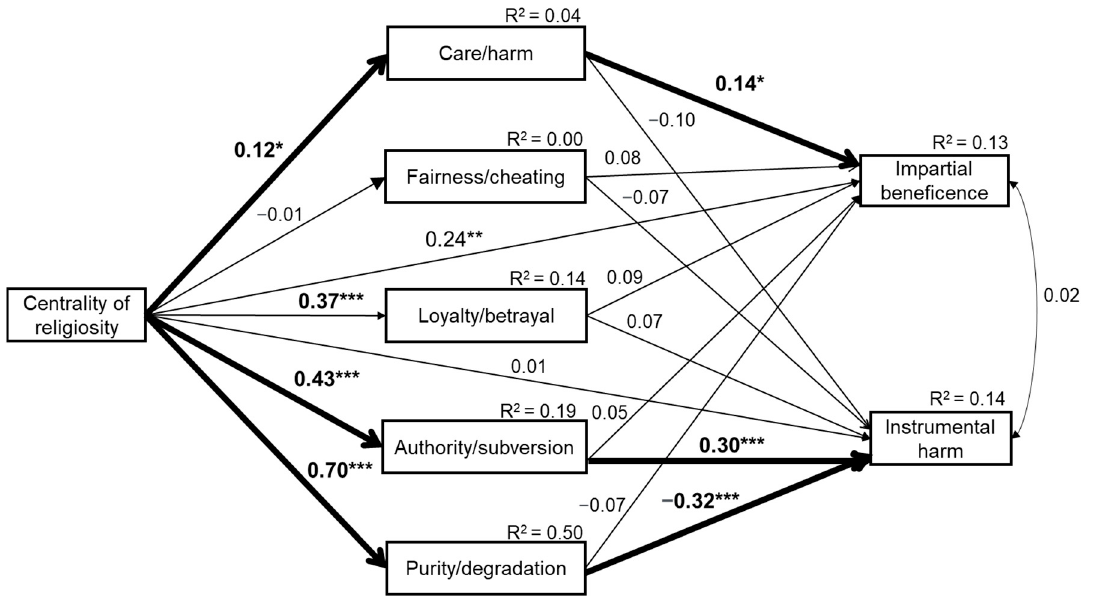
Figure 1. Multiple Mediation Model. * p < 0.05, ** p < 0.01, *** p < 0.001. The regression coefficients are displayed in a standardized form. Significant indirect effect pathways and estimates are presented in bold. The control variables (i.e., gender and age), residuals, and correlations between the residuals of moral foundations are omitted for legibility. N = 401.